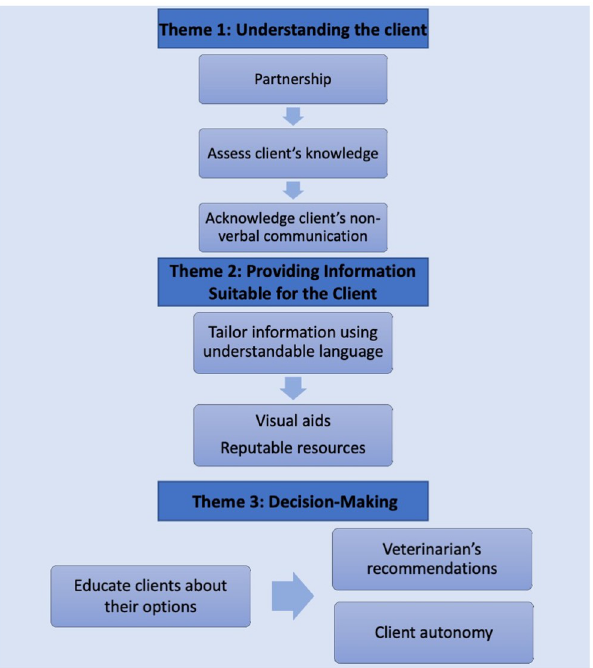
Fig 1. A concept map of the themes and subthemes related to information exchange and decision-making expectations that emerged from pet owner focus groups. Concepts move from top to bottom and are presented in the order in which they may logically flow within a